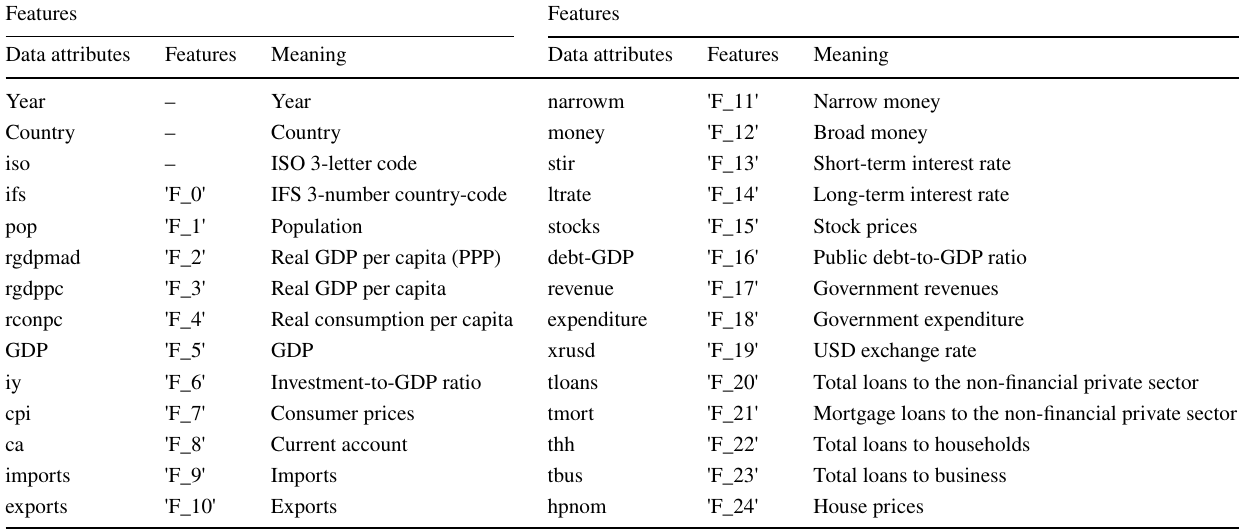
Table 3 The description of used features in the dataset Features